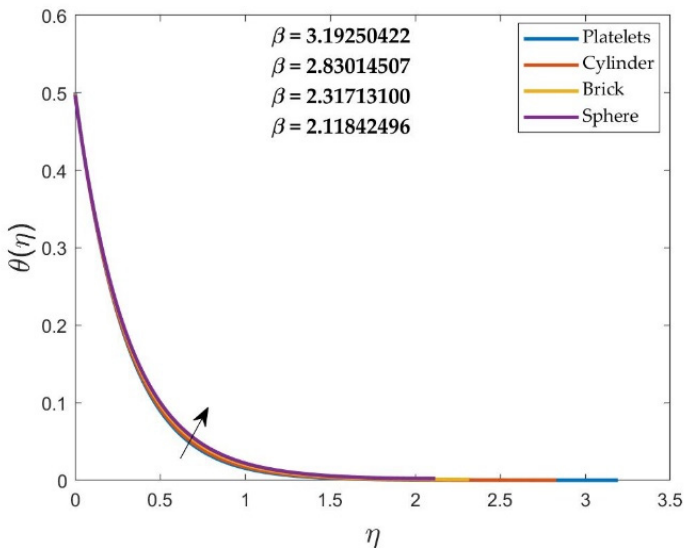
Figure 8. Impact of shape factor on the temperature profile for S = 0.4, K = 0.5, ϕ = 0.02, M = 1.0, Bi = 3.0, λ = − 2.0, α = π /4 and Pr = 8.0 .